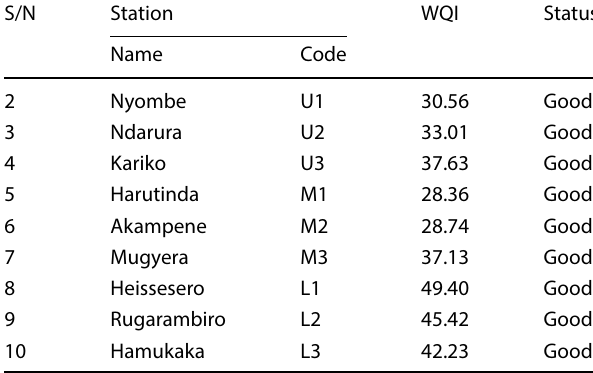
Table 8 Relative weight of parameters WQI determination Variables